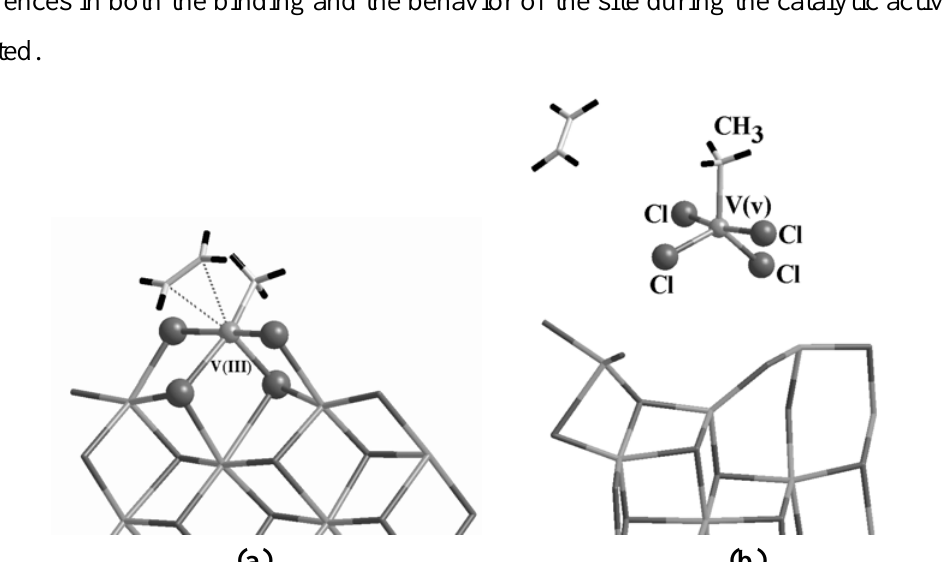
(a) as deduced by analogies with the 2